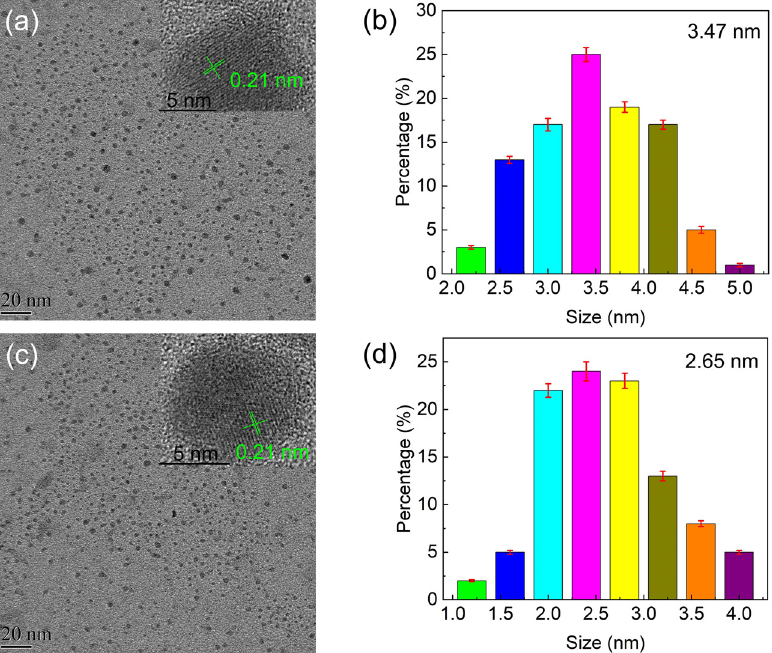
Figure 2: TEM images of ( a ) RCQDs and ( c ) SCWE - CQDs, insets are HRTEM images demonstrating the well - dispersive CQDs. The size distribution histograms of ( b ) RCQDs and ( d ) SCWE - CQDs show an average diameter of 3.47 and 2.65 nm, respectively.